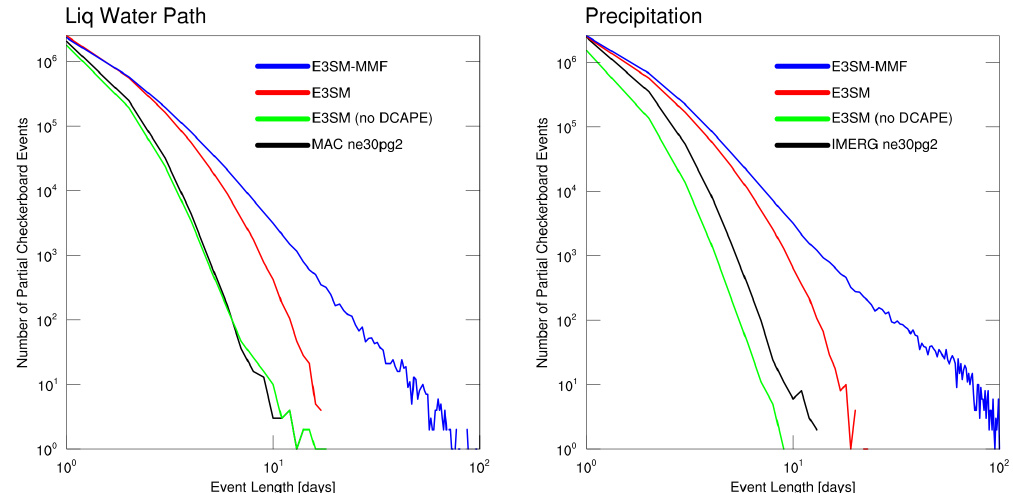
Figure 11. Histogram of the event length, with events defined as continuous periods with partial checkerboard neighborhood state. Data were restricted to oceanic points equatorward of 60 ◦ latitude in both hemispheres for all 5 years that were available.